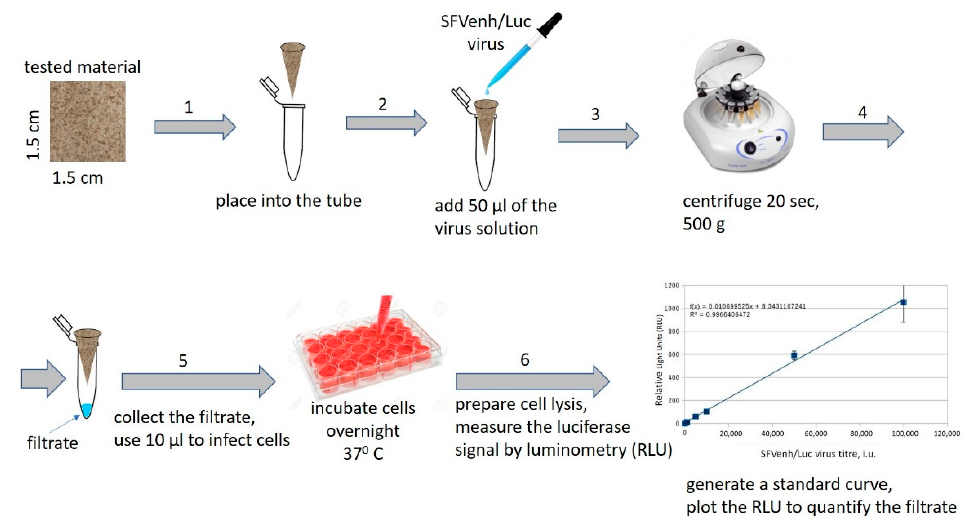
Figure 1. Schematic representation of the virus filtration test (technical details are provided in text). (1) 1.5 cm × 1.5 cm filter sample is cut out from each material, folded into the form of a conical funnel, and placed into a 1.5 mL tube; (2) 50 µ L of recombinant Semliki forest virus (SFV)-enh/Luc virus solution (107 i.u./mL) is added into the cone; (3) the tube is centrifuged to allow the virus to pass through the material; (4) the filtrate (indicated by arrow) is collected; (5) the filtrated is diluted and used for cell infection in a 24-well cell culture plate; (6) after overnight incubation of the plate the cell lysates are prepared and the virus infection is measured by detection of the luciferase activity in infected cells (luminometry). The cell infection with the standard dilutions of the virus is used to generate a standard curve and to calculate the amount of virus in the